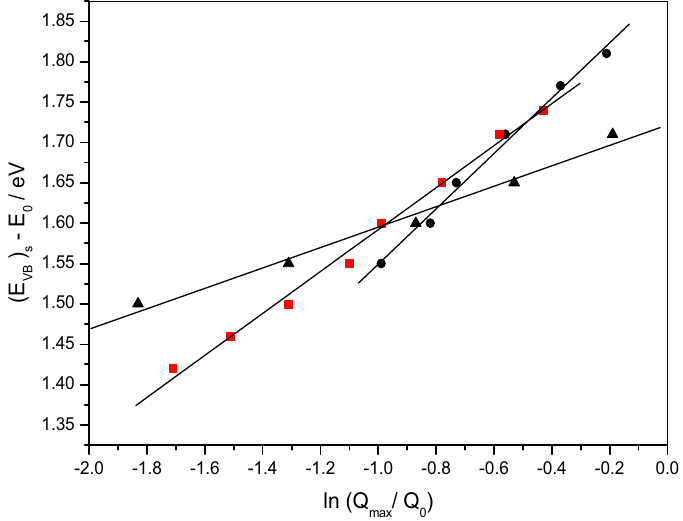
Fig. 2 Plot of the energy (in eV) of the photons emitted in the electroluminescence spec- trum according to the values of λ max (converted to energy values by means of the equiva- lence: E ( eV ) = 1240 eV ), as a function of the logarithm of the relative charge of oxidation λ ( nm ) (ln(Q max /Q 0 ), where Q 0 is the charge necessary for the complete oxidation; see Eq. 16 and Table 1) for three different values of the porosity: (cid:13) 65%;, (cid:3) 70% and ∆, 80%. These energy values have been supposed to be equal to the difference (E V B ) s − E 0 in Eq. (16). Data are taken from the results of